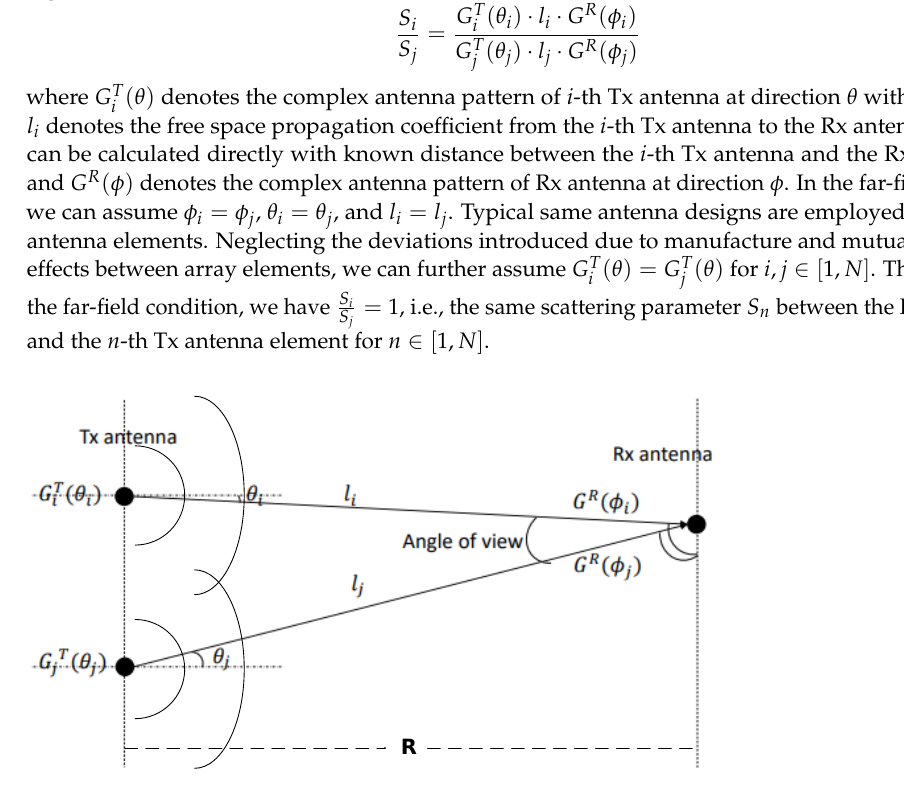
Figure 10. Illustration of the measurement